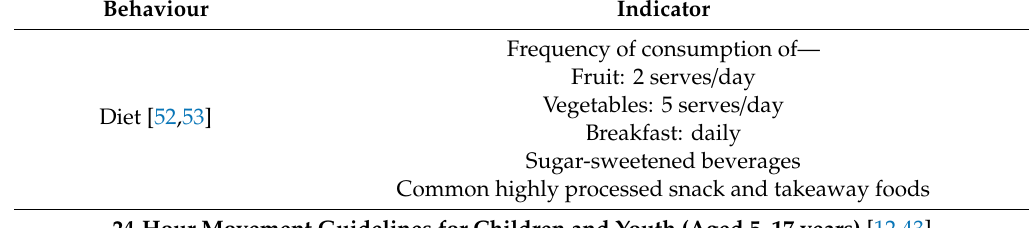
Table 2. International recommendations for weight-related behaviours for children age 5–17 years. Behaviour Indicator Frequency of consumption of— Fruit: 2 serves / day Vegetables: 5 serves / day Diet [52,53] Breakfast: daily Sugar-sweetened beverages Common highly processed snack and takeaway